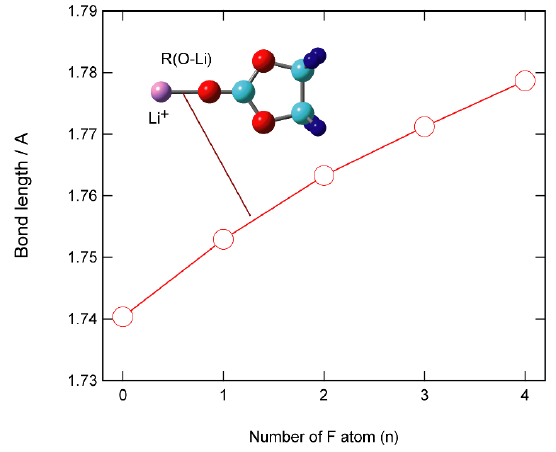
Figure 4. Bond lengths of the Li + ‐ oxygen atom of Li ‐ EC complexes plotted as a function of the number of F ‐ atoms. The values were calculated at the B3LYP/6 ‐ 31G(d) level.